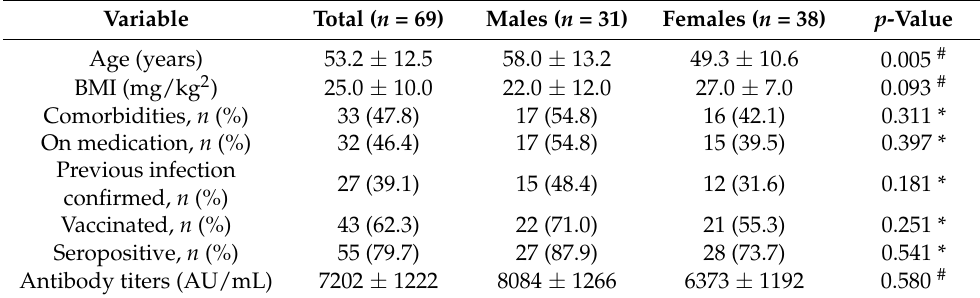
Table 1. Characteristics of the study population, stratified by gender (N = 69).